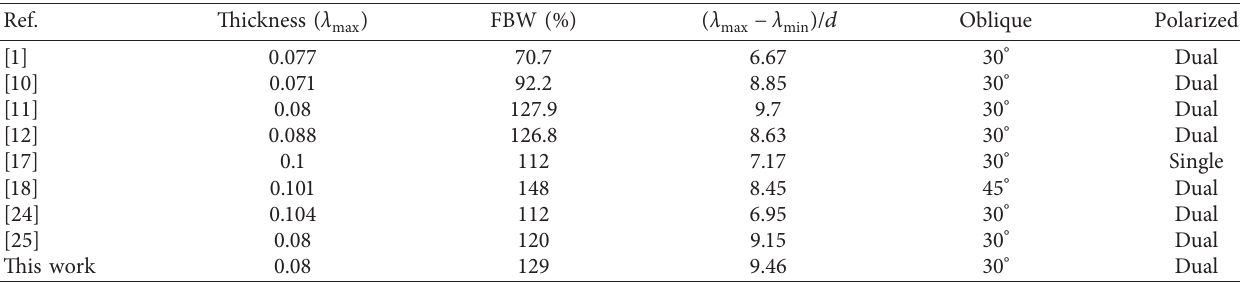
Figure 9: Simulated and measured results of the proposed absorber under oblique incidences for (a) TE polarization and (b) TM polarization. Table 1: Performance